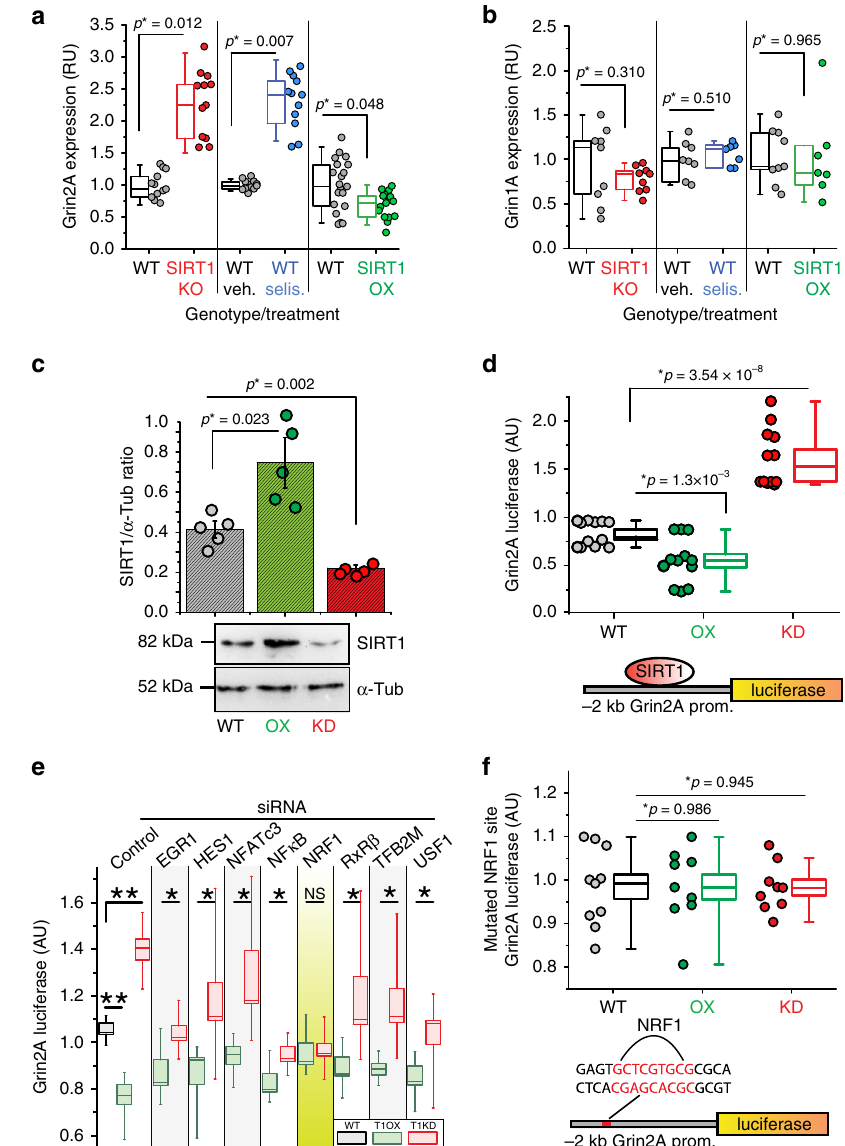
Fig. 3 SIRT1 activity, mediated by NRF1, suppresses the expression of Grin2A. a RT-qPCR expression analysis of Grin2A in the cortex of BSKO- (red), BSOX- (green), and selisistat- (selis.) (blue) treated mice, n ≥ 12. b Expression analysis of Grin1A gene in the same mice as in a , n ≥ 7. c , d Modulation of SIRT1 abundance in vitro in Neuro-2a cells directly in fl uences the activity of the Grin2A promoter. c SIRT1 protein levels in Neuro-2a cells are shown, together with an example of a typical SDS-PAGE, n ≥ 5. d The activity of the Grin2A-luciferase reporter in the same cells as in c is presented, n ≥ 12. e Using siRNAs for eight transcription factors (TFs), we transfected Neuro-2a cells along with the 2 kb Grin2A promoter, and T1OX or T1KO constructs. NRF1 was the only TF that eliminated the impact of SIRT1 on Grin2A transcription, n ≥ 6. f Transfecting Neuro-2a cells with a Grin2A promoter with its NRF1-binding site mutated and the T1KO and T1OX constructs resulted in a complete loss of responsiveness to SIRT1, n ≥ 9. P values were calculated using unpaired two- tailed t tests, * P < 0.05, ** P < 0.005. Error bars are SEM. The box-plots represent the median, 25th, and 75th percentiles of the data and the whiskers represent 5 – 95% of the data. NS, not signi fi cant. Source data are provided as a Source Data fi